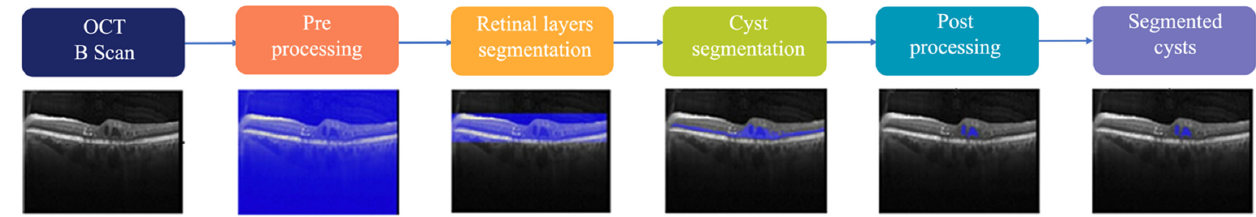
Figure 4. Workflow of classical machine learning in OCT cyst segmentation problem. The OCT image was reprinted with permission from Ref. [46]. 2020, Ganjee.